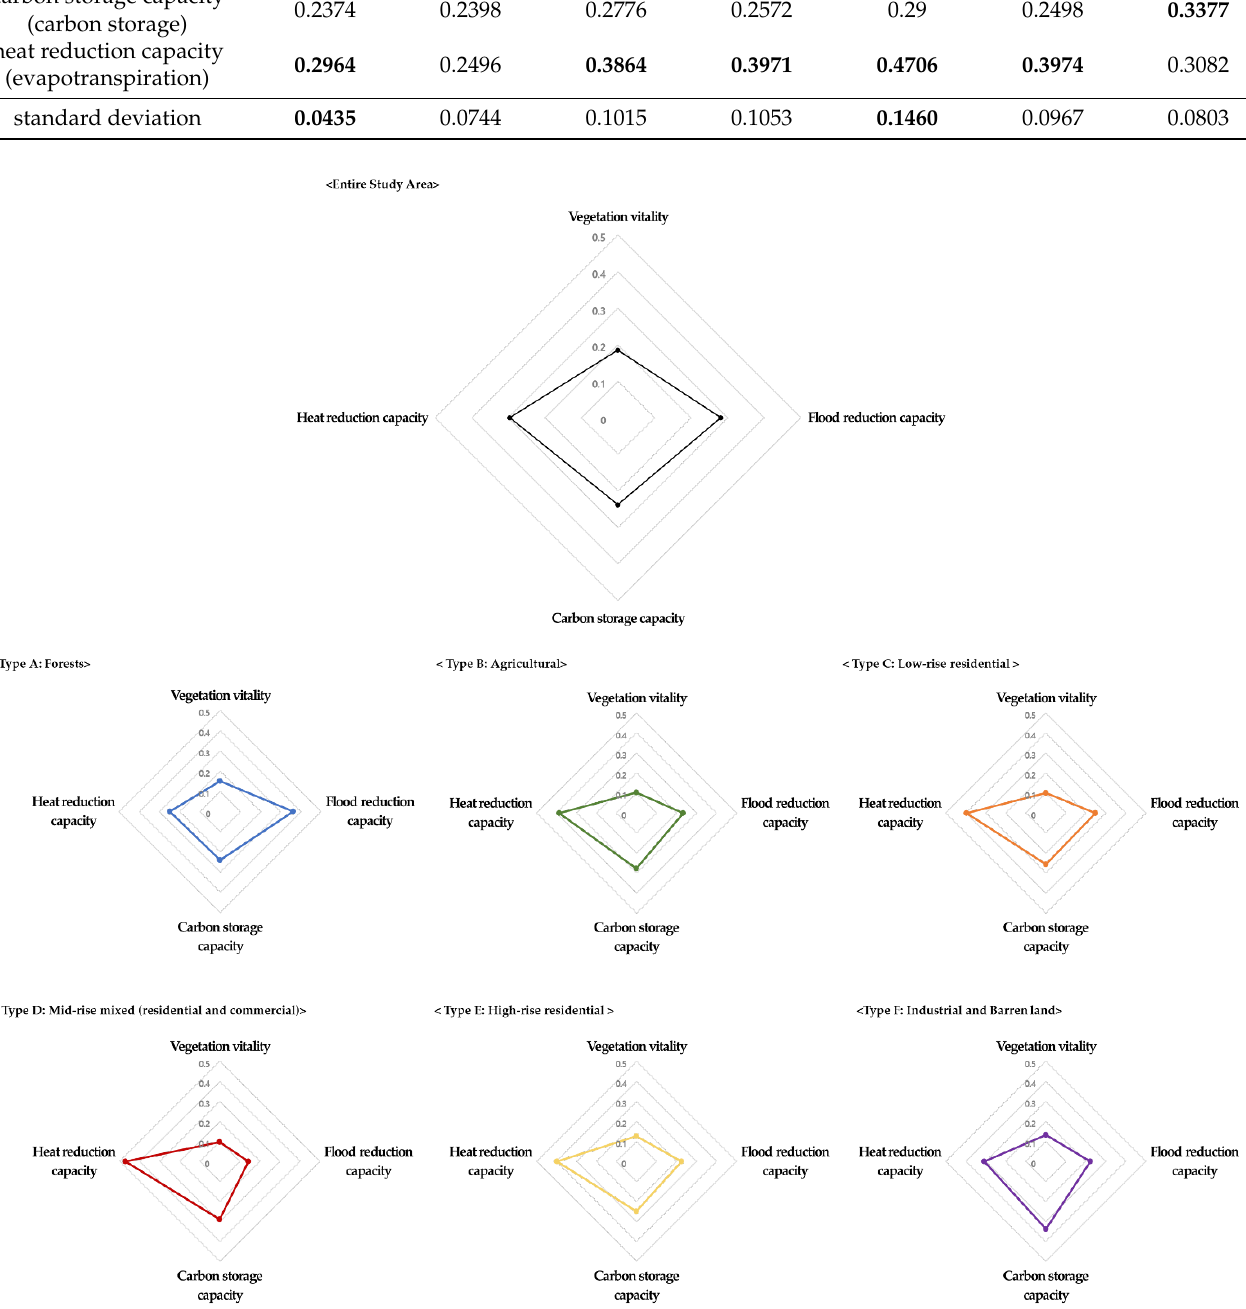
Figure 6. Results of the relative contribution analysis of urban ERS spider diagram.